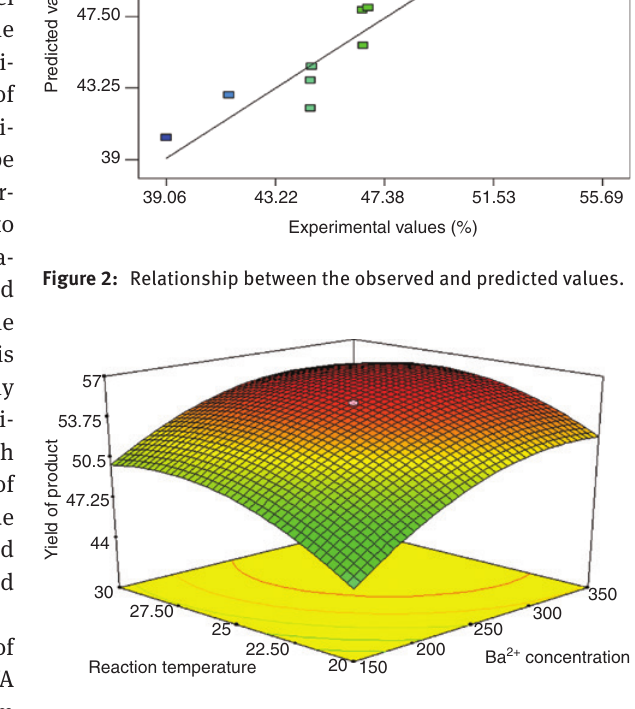
Figure 3: Response surface for effect of Ba 2 + concentration and reaction temperature on yield.